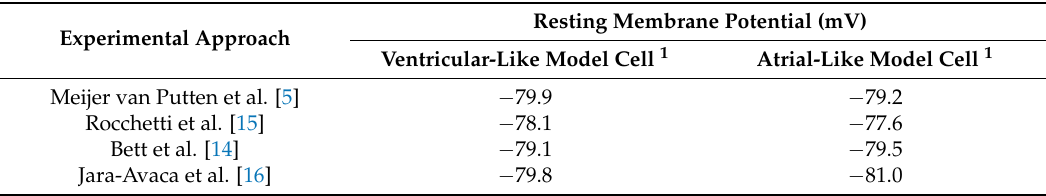
Table 3. Resting membrane potential evoked in hiPSC-CM model cell.